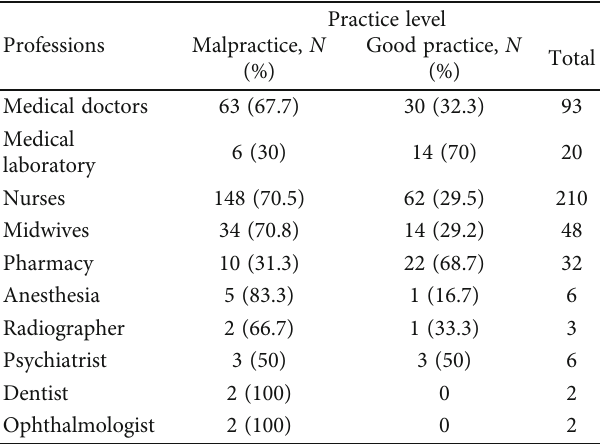
Table 7: Practice levels of the health care professionals about HBV early detection, transmission, and prevention at Tibebe Ghion Specialized Hospital from January 1 to February 30, 2021.